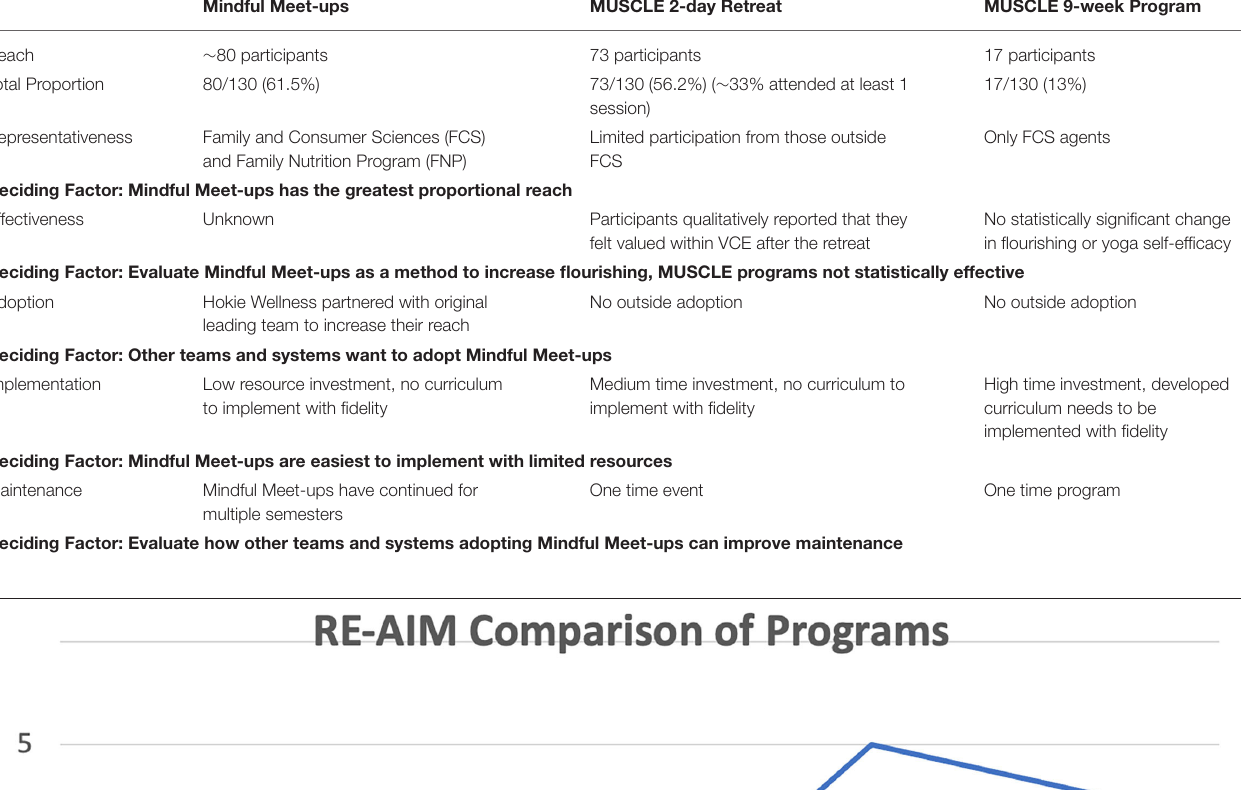
TABLE 1 | Application of RE-AIM dimensions across three mindfulness programs. Mindful Meet-ups MUSCLE 2-day Retreat MUSCLE 9-week Program